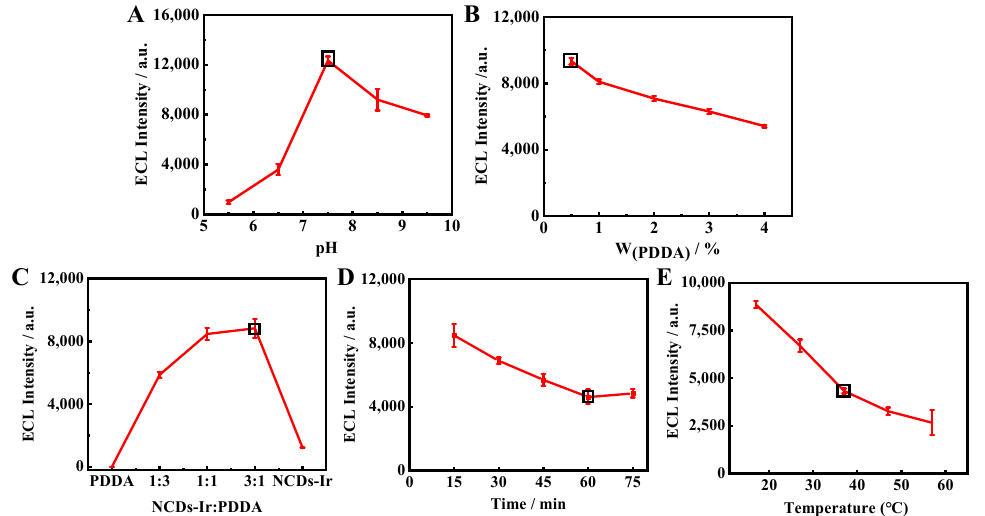
Figure 4. Optimization of the reaction conditions: ( A ) the pH of the PBS buffer solution; ( B ) the amount of PDDA; ( C ) the mixing ratio of Ir − NCDs and PDDA; ( D ) the incubation time of the modified antigen on the electrode; ( E ) the incubation temperature of the modified antigen on the electrode .